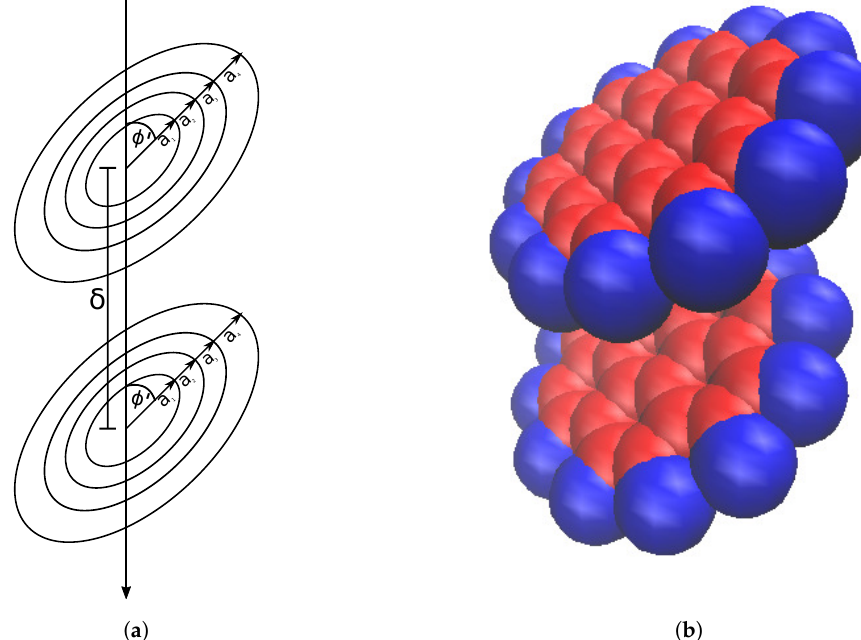
Figure 3. Coronene dimer represented by ( a ) concentric circular rings and ( b ) space filling model.